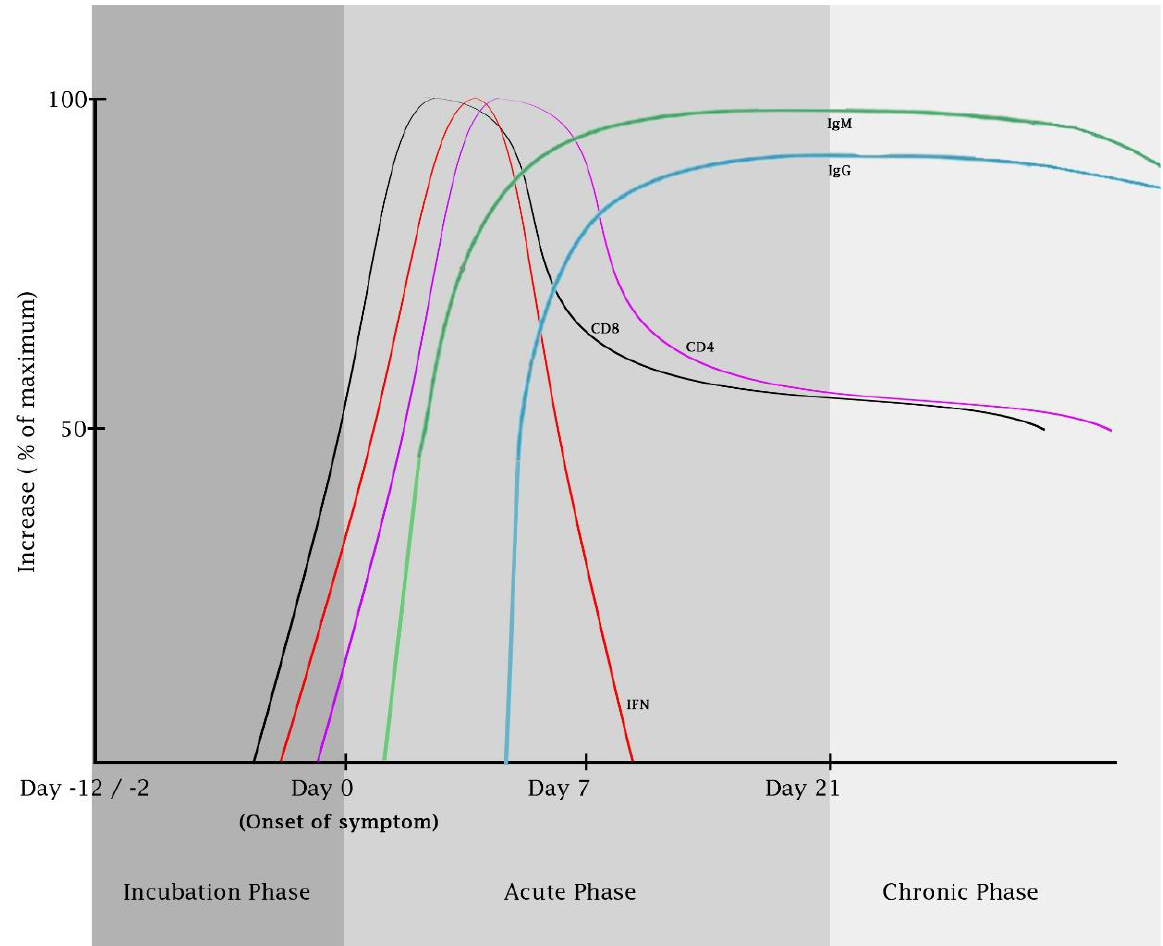
Figure 3. The kinetics of immune responses against CHIKV infection. The level of IFN peaks at between 0 and 5 after symptom onset [110]. The activation of CD8 and CD4 T cells peaks at day 1 and 4 after symptom onset, respectively. The functional CD4 and CD8 T cell responses are detectable at 12 to 24 months post-infection [71]. Anti-CHIKV IgM gradually increased from as early as day 2 – 4 after symptom onset and then remained stable until 4-10 months [111 – 114]. Anti-CHIKV IgG is